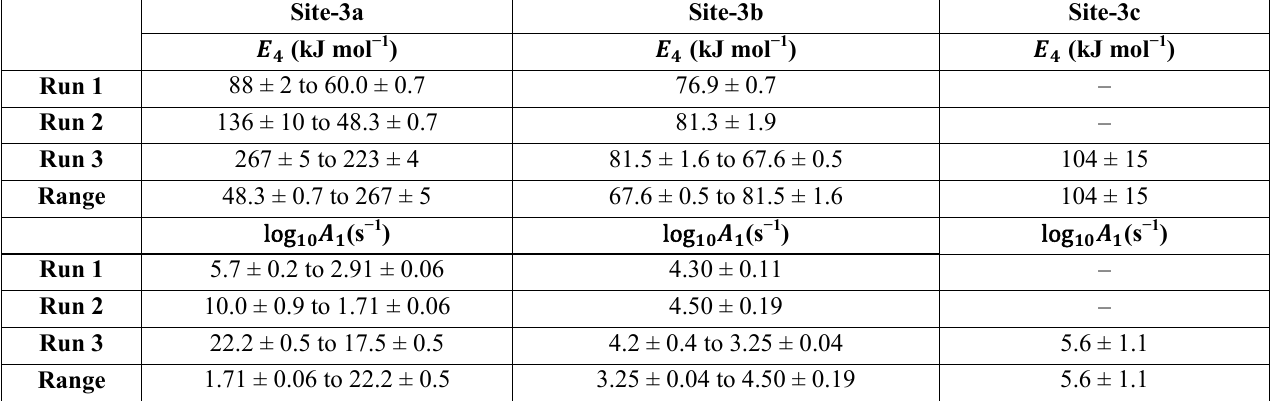
Table 6. Intrinsic isobutene dimerization activation energies ( (cid:1831) ) calculated from Equations (21) and (22) for the three runs. Isobutene diffusion ( log (cid:1827) (cid:2869)(cid:2868) (cid:2869) activation energy is (cid:1831) (cid:3404) 56.5 kJ mol − 1 [1] and (cid:1831) (cid:2873)